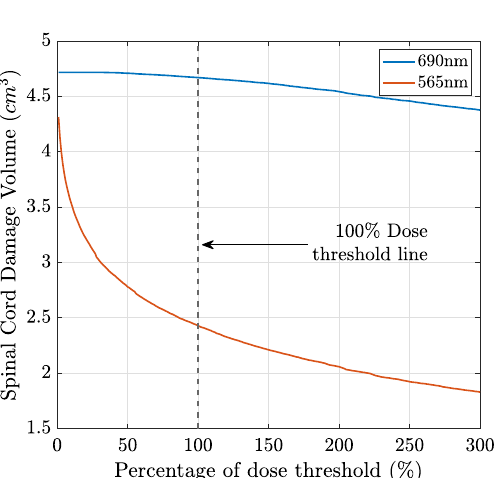
Figure 2. Central axial slice of the metastatically involved T8 vertebra with the surrounding healthy tissues. For treatment planning, the metastasis (dark blue) is considered the target and the spinal cord (light blue) is the primary organ at risk. For illustrative purposes, the bone is shown in light blue, and the muscle is made transparent.